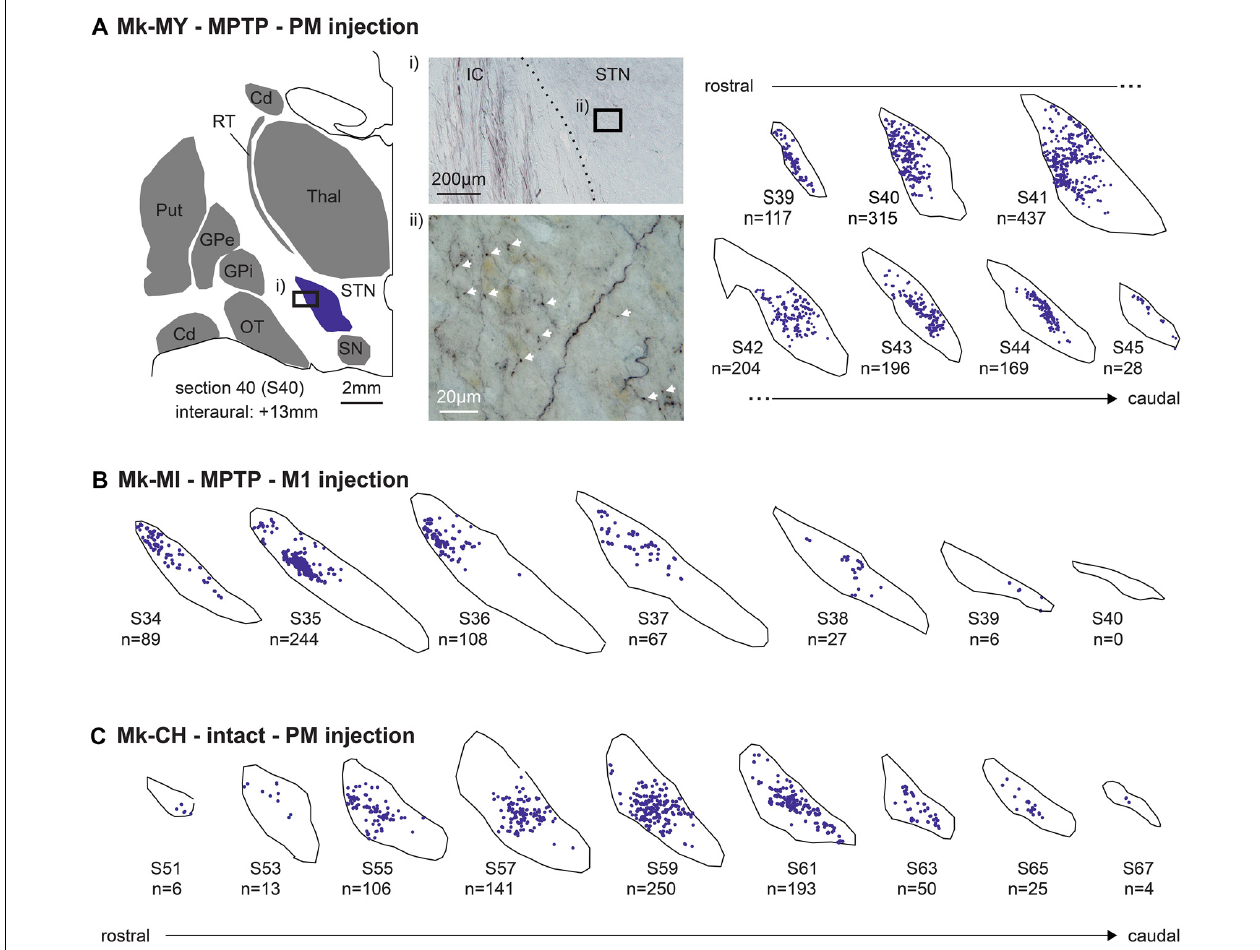
FIGURE 2 | Typical distribution of BDA-labeled corticosubthalamic axonal boutons in the ipsilateral subthalamic nucleus (STN) in three representative monkeys, two subjected to 1-methyl-4-phenyl-1,2,3,6-tetrahydropyridine (MPTP) intoxication [Mk-MY and Mk-MI, (A) and (B) ] and one intact monkey [Mk-CH, (C) ]. BDA was injected in PM in Mk-MY and Mk-CH, whereas it was injected in M1 in Mk-MI. Axonal boutons are depicted with blue dots on the consecutive sections of STN, from rostral to caudal. (A) For Mk-MY, a lower magnification representation of one section (number 40) is shown in order to show the location of STN with respect to other brain structures. The microphotograph (i) on the top illustrates a typical BDA-labeled terminal field in STN, as well as BDA-labeled passing axons in the adjacent internal capsule (IC). The microphotograph (ii) below is a high magnification of a portion of the BDA-labeled terminal field in STN showing a few axonal boutons (white arrows). Cd, caudate nucleus; GP, globus pallidus; OT, optic tract; Put, putamen; RT, reticular nucleus of the thalamus; SN, substantia nigra; Thal,